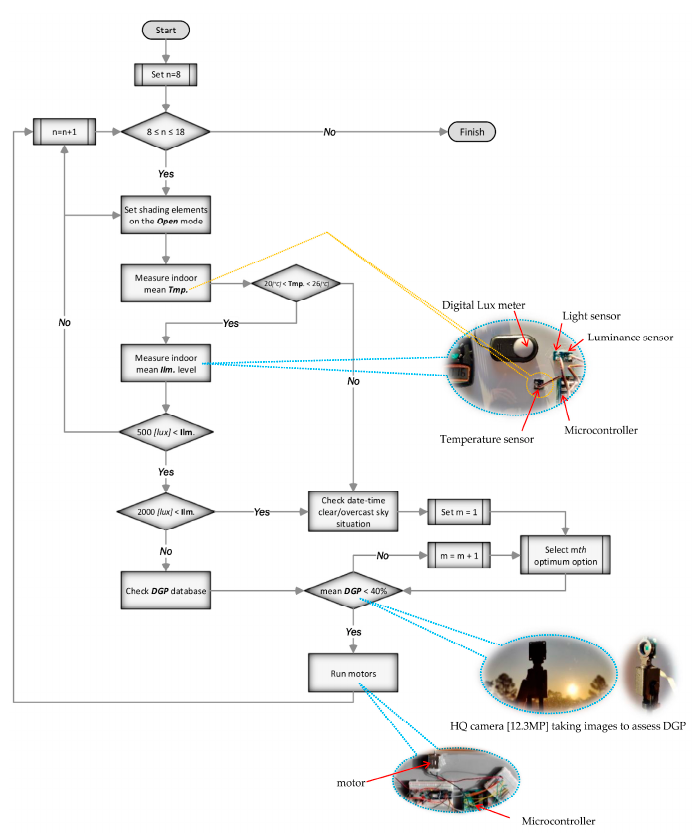
Figure 16. Block diagram showing steps of operating shading system. The system was updated every hour (18 times a day).